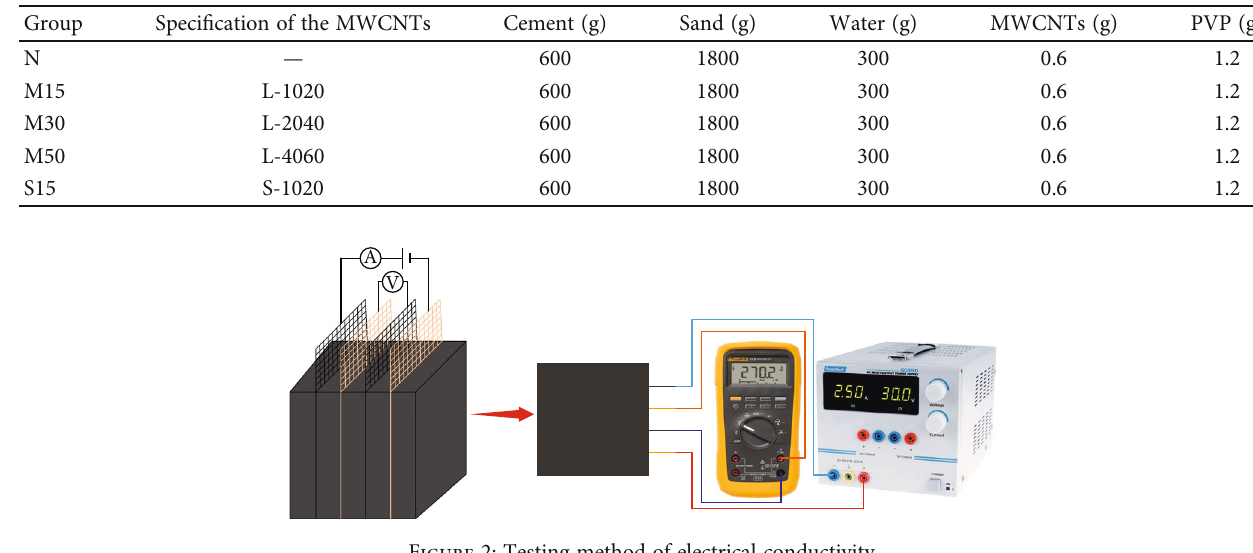
Table 4: Mix design of cement mortar.